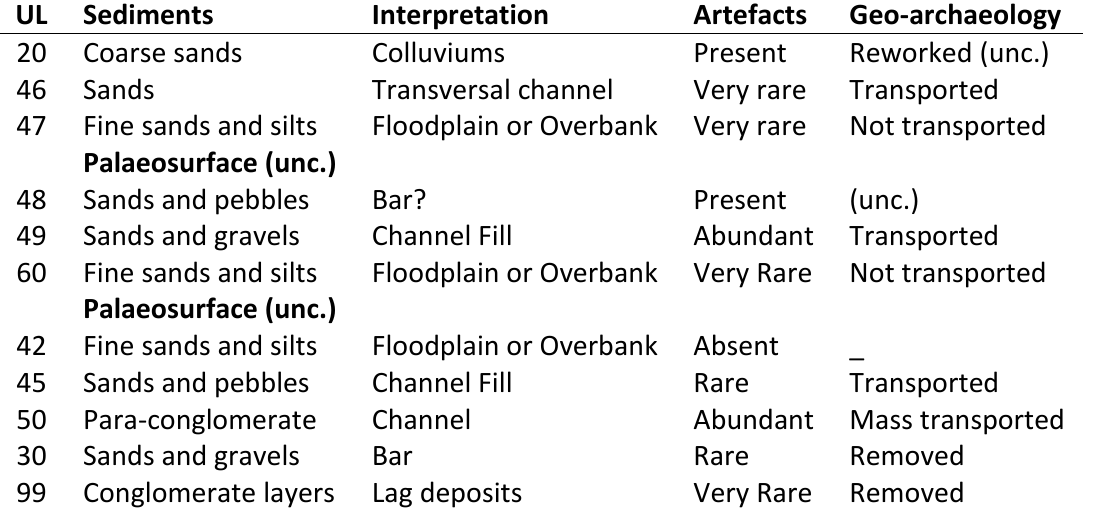
Table 1. Lithological Units description and geo-archaeological interpretation. Abbreviation: unc. -